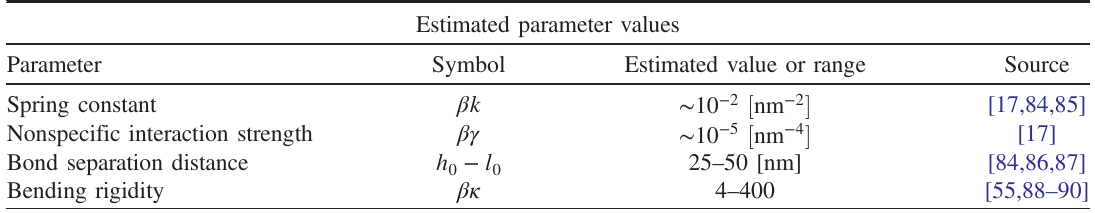
TABLE I. Estimated parameter values in cellular